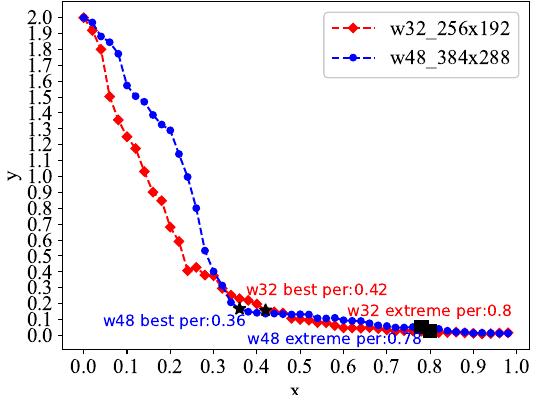
Figure 4. Candidate model